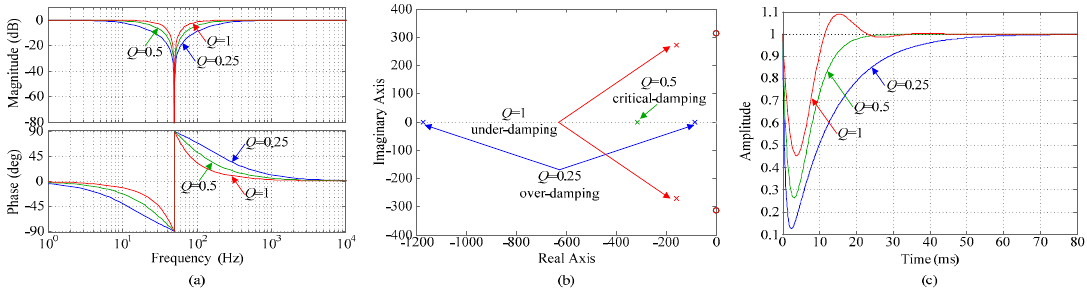
Figure 7. Analysis diagrams of notch filter with Q = 0.25, 0.5, 1. ( a ) The Bode diagram of notch filter; ( b ) Pole-zero plot of notch filter; ( c ) Unit step dynamic responses of notch filter.